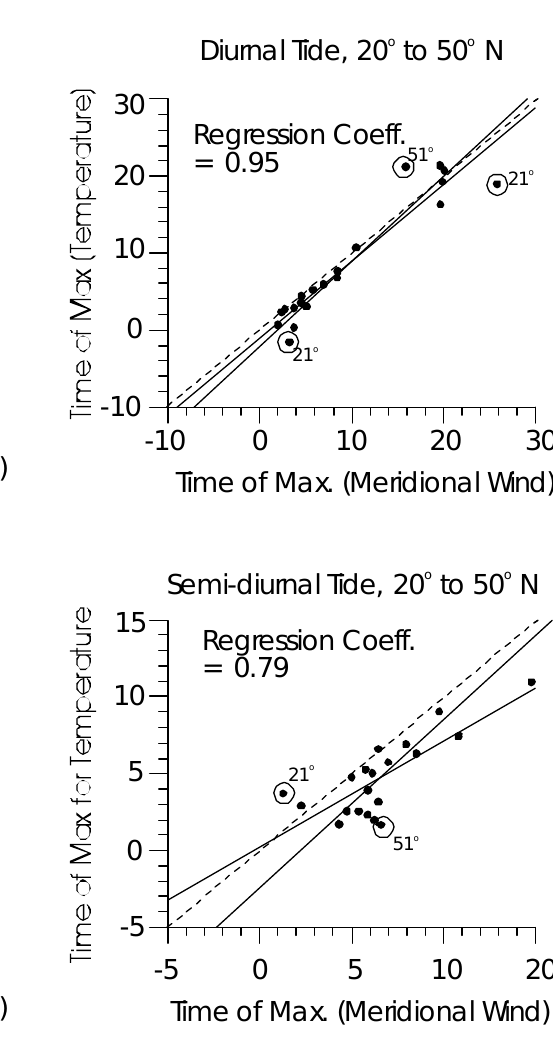
Fig. 14. Scatter plots of the phases of the temperature tides vs. the phases of the meridional winds as determined from the GSWM for the latitude band 20 ◦ N to 50 ◦ N for (a) the diurnal and (b) the Fig.14 semidiurnal tides. The origin of some of the outliers are also indi- cated. In each case the broken line indicates the 1:1 line, and the solid lines represent least-squares fits of the regression of the ab- scissa on the ordinate, and the ordinate on the